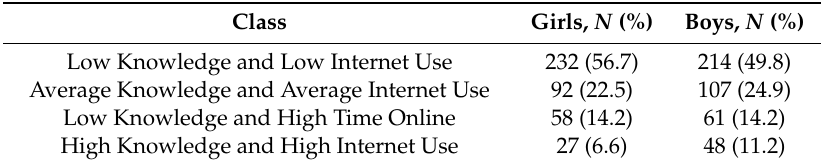
Table 5. Number of boys and girls in each class.